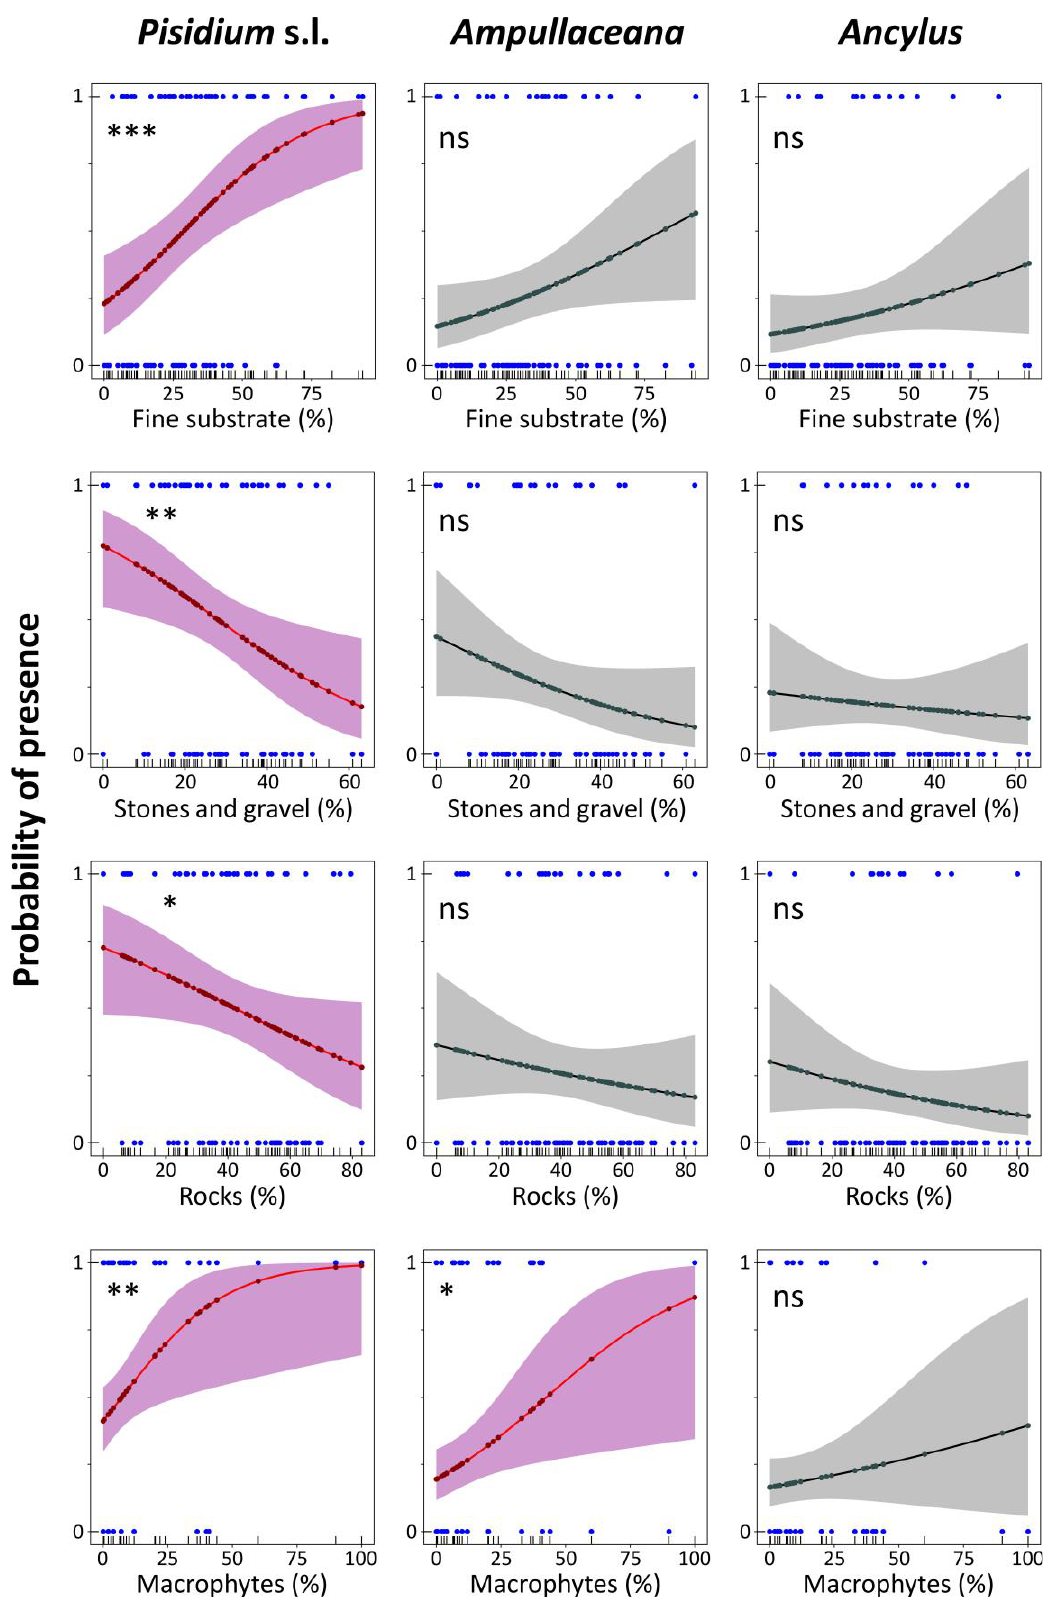
Figure 7. Logistic regression models for Pisidium s.l., Ampullaceana balthica , and Ancylus fluviatilis concerning habitat substrate dominance and macrophyte coverage. Level of significance follows a chi-square test on a deviance table: ns, not significant; *, p < 0.05; **, p < 0.01; ***, p < 0.001.